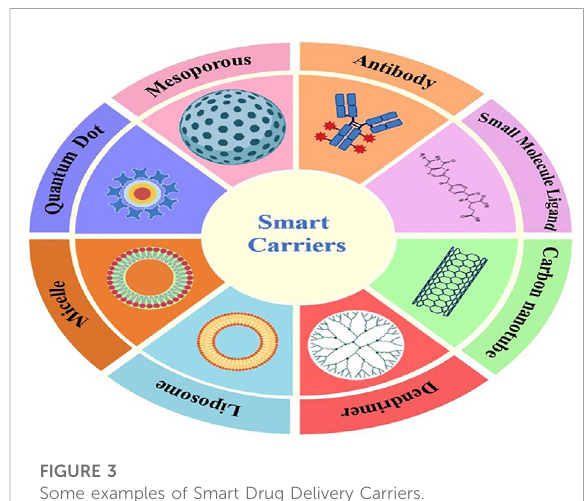
FIGURE 3 Some examples of Smart Drug Delivery